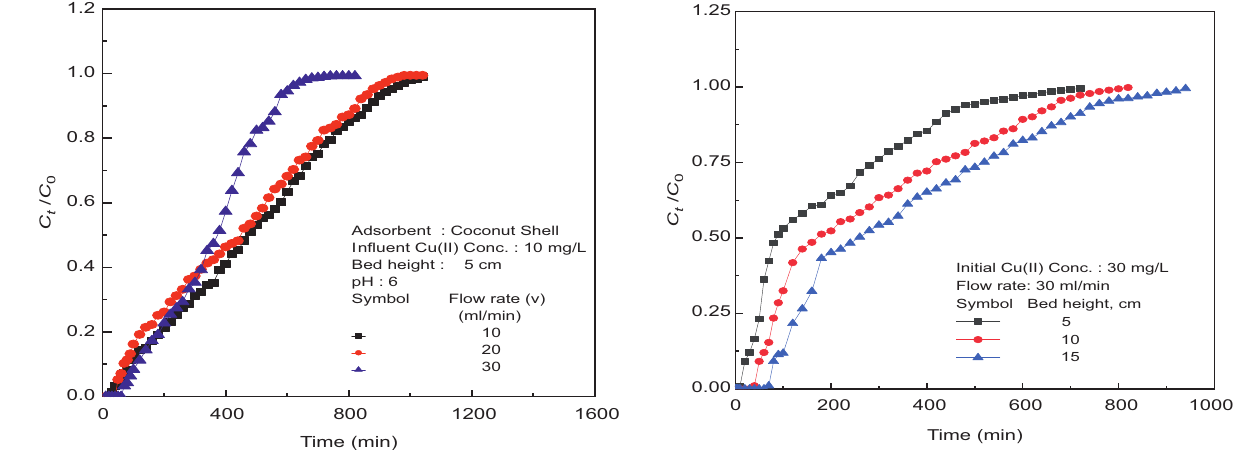
Figure 6. Effect of bed height of column for removal of Cu(II) on coconut shell constant flow rate and influent metal ion